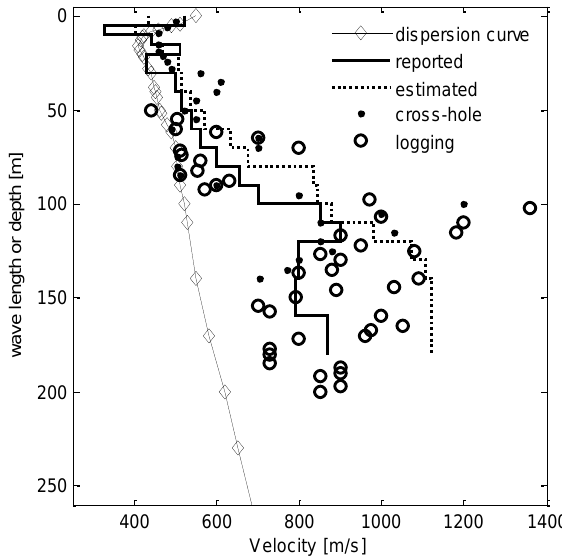
Figure 12. Estimated shear velocity profiles in comparison with the reported result by Joh [8]. (The vertical axis scale is the wavelength for the dispersion curve and depth for